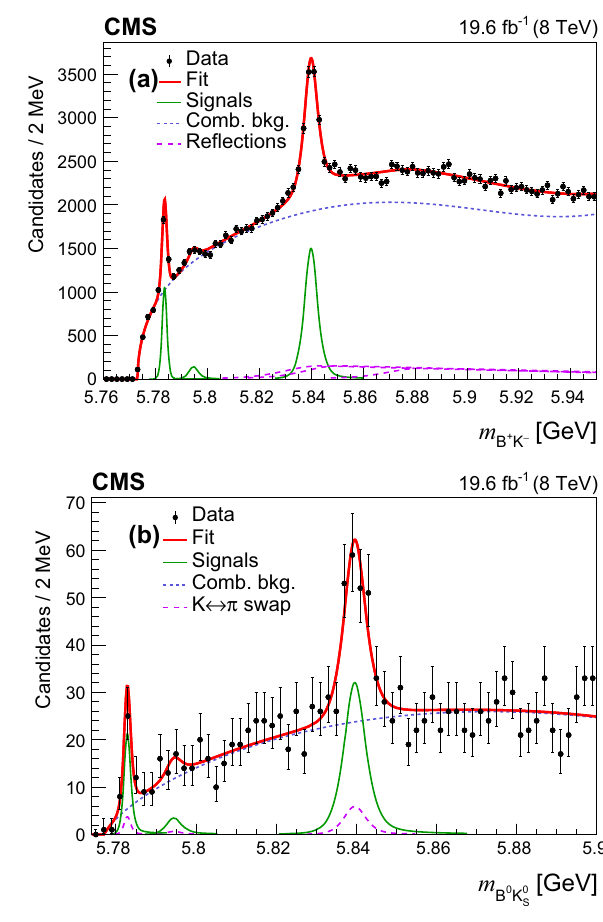
Fig. 3 Invariant mass distributions of a B + K − and b B 0 K 0 with the results of the fit overlaid. The points represent the data, the thick solid curves are the results of the overall fits, and the thin solid lines display the signal contributions. The short-dashed lines show the combinatorial background contributions. The long-dashed lines show: in a the contributions from excited B 0 meson decays, and in b the contributions from swapping K ± → π ± in the reconstruction of the B 0